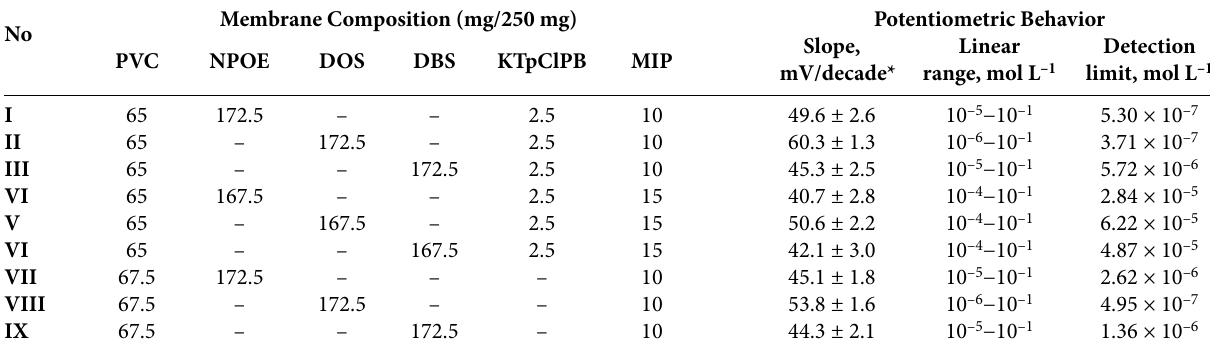
Table 1. Potentiometric performance characteristics of DOP–selective microsensors